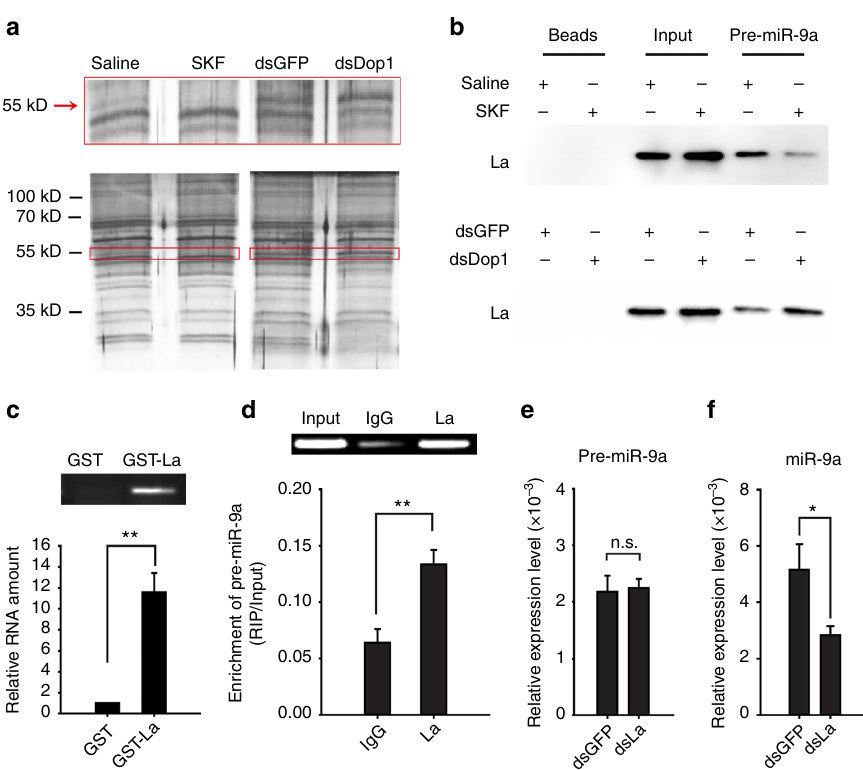
Fig. 8 Dop1 inhibits miR-9a maturation by preventing the direct binding of the La protein with pre-miR-9a. a Pre-miR-9a RNA pull down in brain tissue extracts with Dop1 activation and RNAi knockdown. The 55 kD protein (red frame) showed the reversal change after Dop1 activation and knockdown. b Western blot analysis of the amount of La protein in RNA pull-down outputs from the brain tissue extracts treated with either Dop1 activation or RNAi knockdown. c RT-PCR and qPCR analyses of pre-miR-9a expression after pulling down with GST and GST – La fusion protein ( n = 4). d RT-PCR and qPCR analyses of pre-miR-9a from La immunoprecipitates from brain tissue extracts ( n = 6). e , f Expression levels of pre-miR-9a ( e , n = 6) and miR-9a ( f , n = 6) after knockdown of the La protein in the brain tissues. The data between controls and treatments were analyzed by Student ’ s t -test and presented as the mean ± SEM. * P < 0.05; ** P < 0.01. SKF: